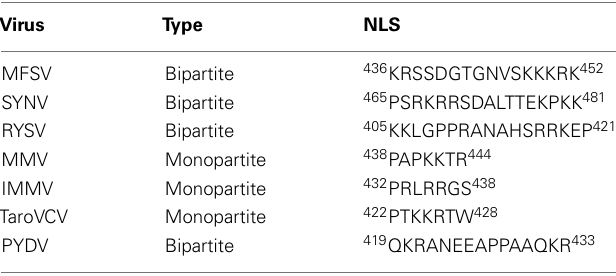
Table 2 |The PYDV-N-NLS was used as a probe in BLASTp searches to identify Arabidopsis proteins with QKR motif